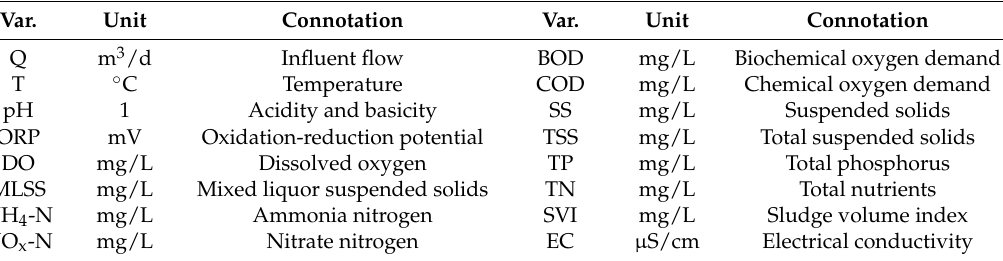
Table 1. Measurable variables and corresponding connotations in